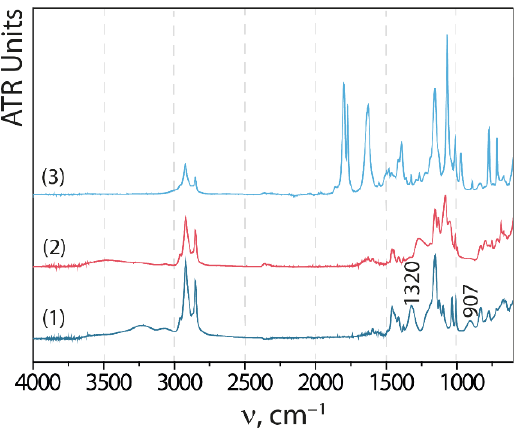
Figure 2. IR spectra of SSEBS-NH 2 (1), SSEBS-Ph (2), and SSEBS-Ph-EC-DMA membranes